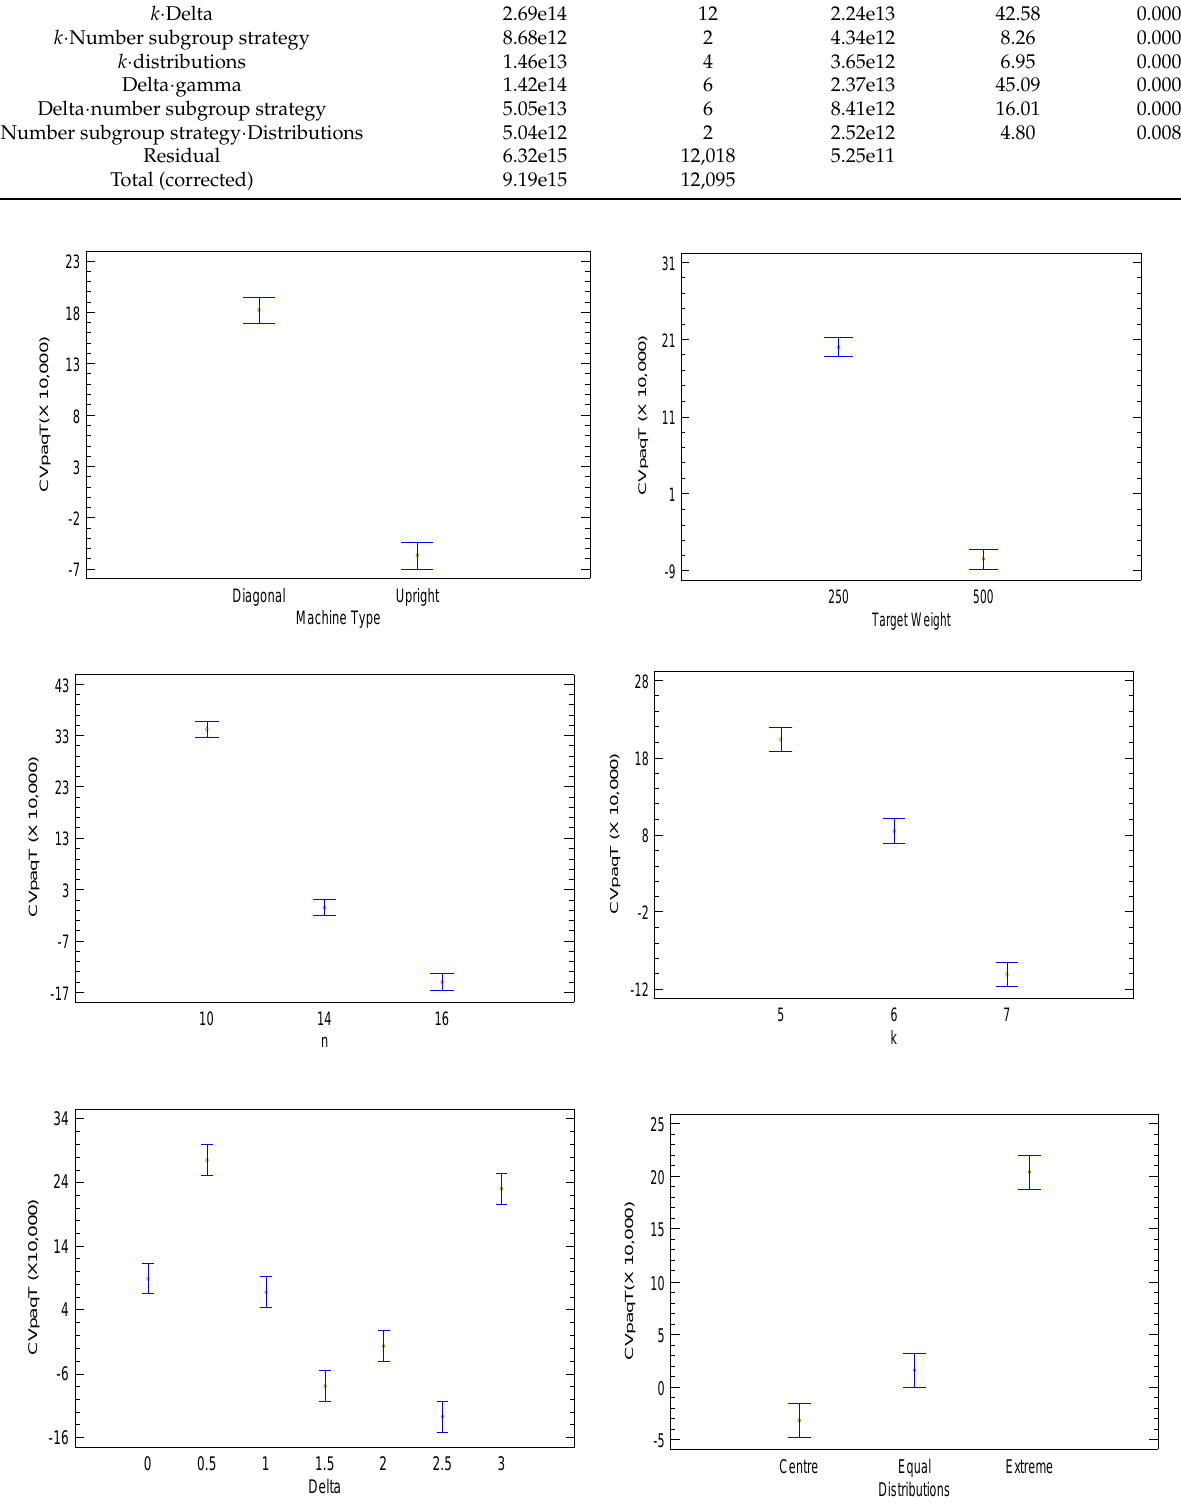
Figure 7. Means and least significant difference (LSD) intervals for the main significant